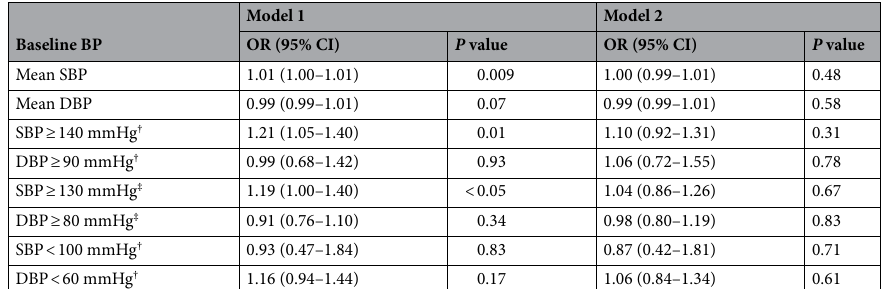
Table 2. Estimated odds ratios (ORs) and 95% confidence intervals (95% CI) of baseline systolic and diastolic blood pressure (SBP and DBP, respectively) for incident dementia at Years 4 to 6. Comparison was made with reference to stable SBP or DBP defined as 100–140 mmHg or 60–90 mmHg, respectively, † or to stable SBP or DBP defined as 100–130 mmHg or 60–80 mmHg, respectively. ‡ Model 1 was unadjusted, whereas Model 2 was adjusted for age, sex, educational level, socioeconomic status, hypertension, diabetes, hypercholesterolemia, obesity, heart diseases, visual impairment, hearing impairment, poor balance, depression, physical exercise, intellectual activities, social activities, fruit and vegetable consumption, smoking, and alcohol use.